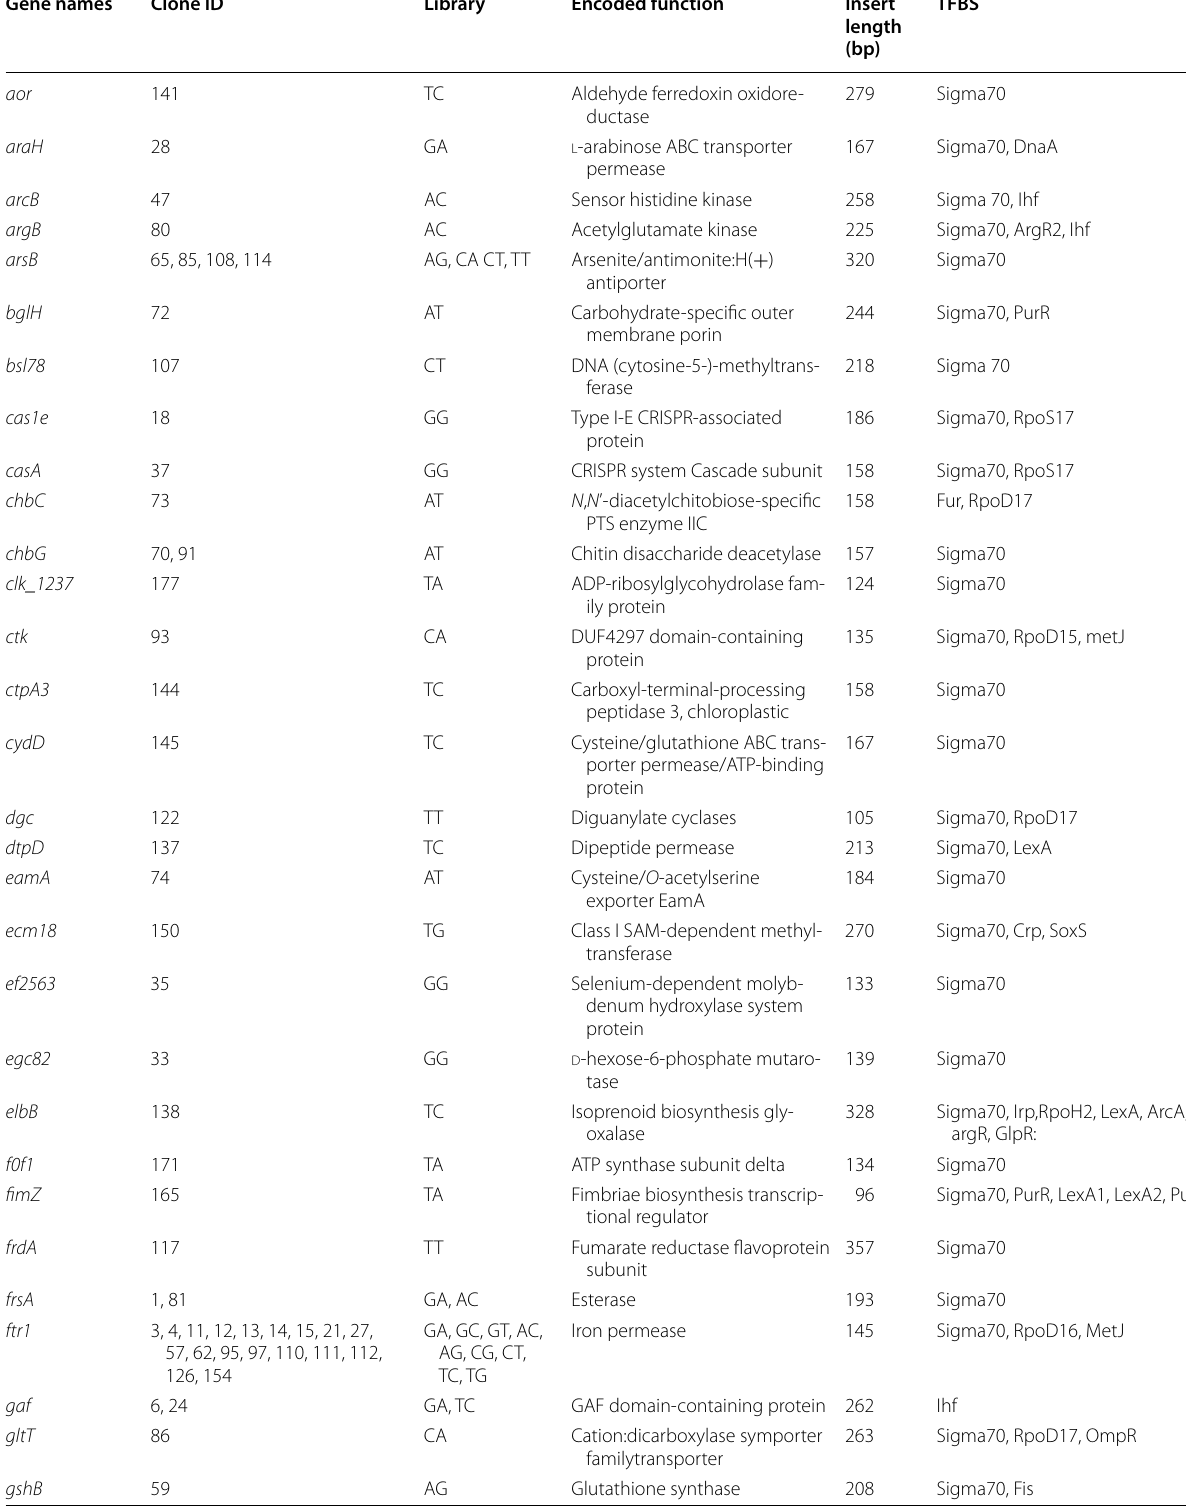
Table 2 List of clones containing with -35 and -10 conservative sequences or TF binding sequences Gene